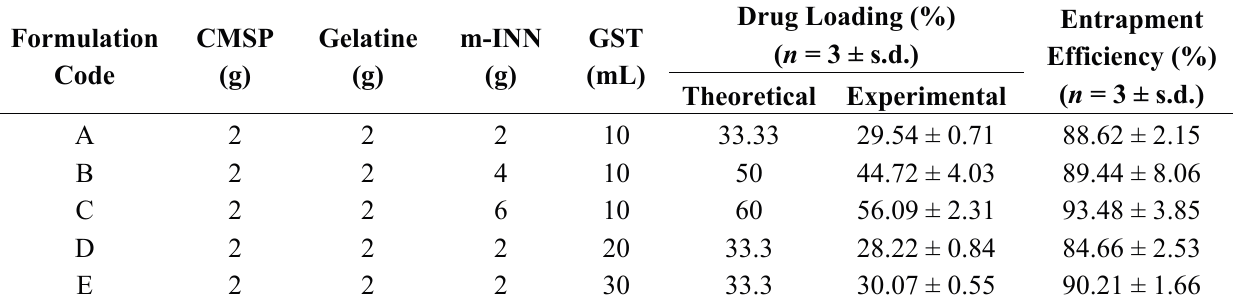
Table 1. Physicochemical parameters of m-INN loaded CMSP-gelatine microcapsules prepared by complex